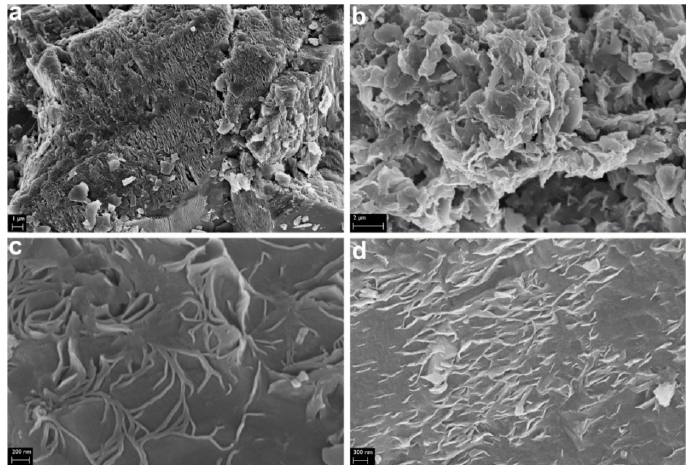
Figure 5. ( a , c ) SEI images of smectite flakes on plagioclase surfaces of andesite (sample BE.101); ( b , d ) SEI images with characteristic smectite flakes on plagioclase crystals of dacite (sample